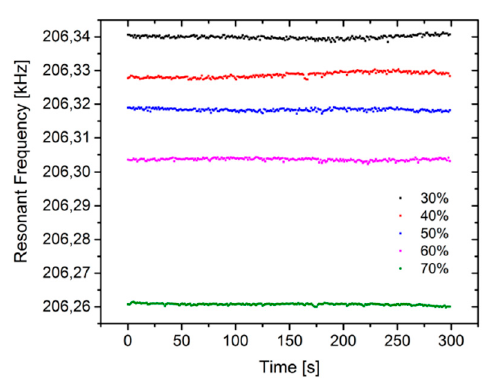
Figure 4. Short time stability of microcantilevers coated with sputtered/annealed ZnO film (200 nm)/chitosan SAMs measured from 30%RH to 70%RH at 25 °C.